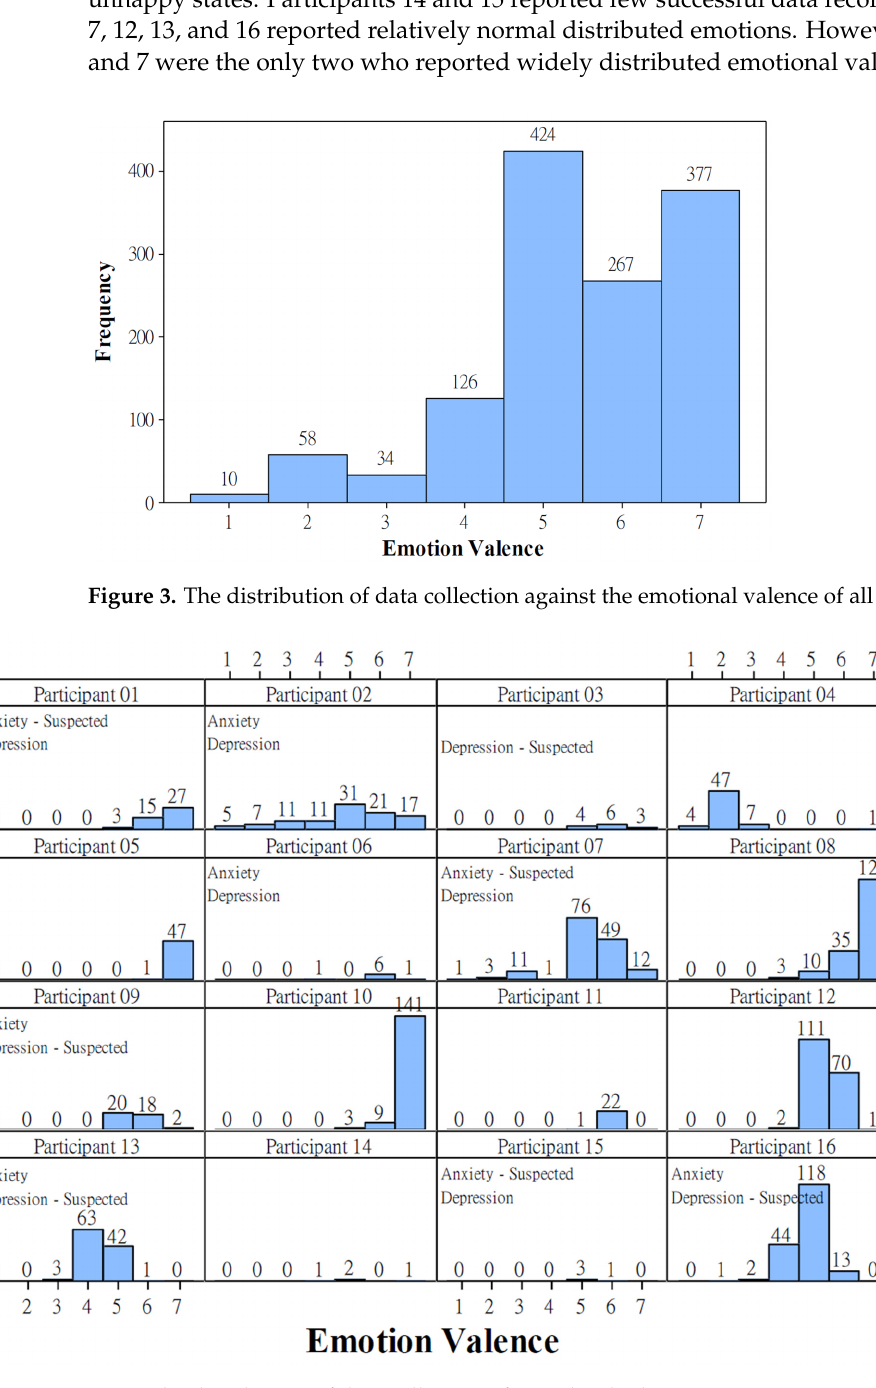
Figure 4. The distribution of data collection of 16 individual participants.